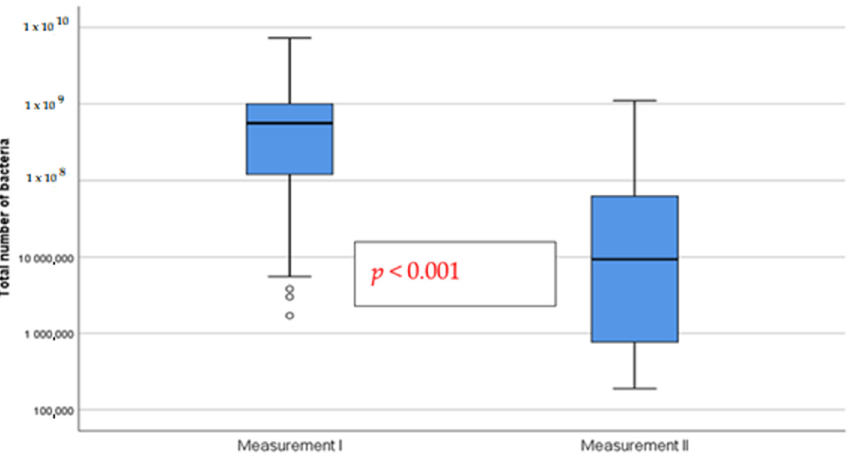
Figure 4. Total number of implant gingival pockets of patients before (measurement I) and after treatment (measurement II) with a bioactive healing abutment containing clindamycin.